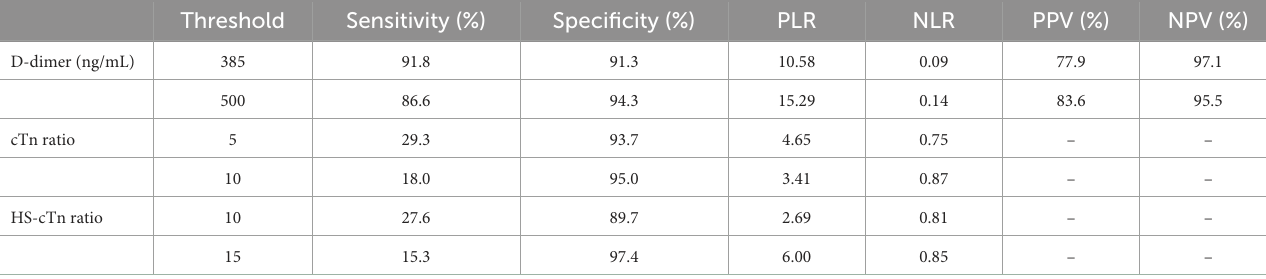
TABLE 6 Diagnostic performance of D-dimer for AAS and cTn ratio for NSTEMI with chest pain onset ≥